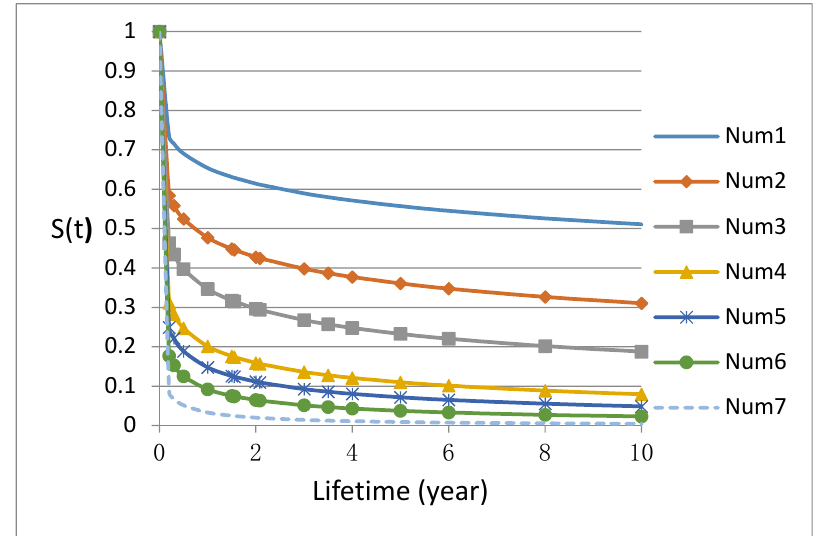
Figure 5. Survival function of the girth weld under the influence of several different factors.